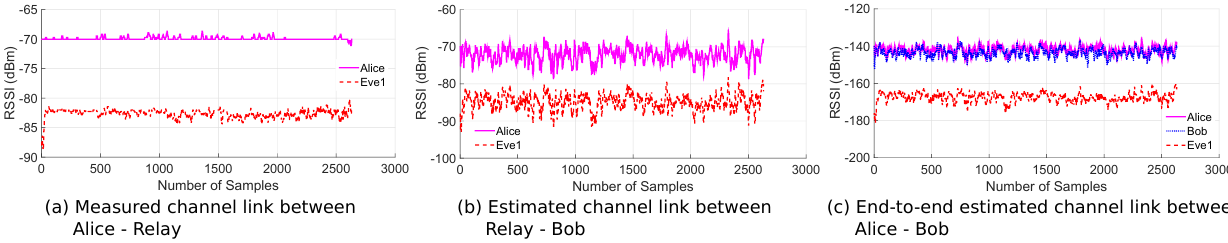
Figure 8: Channel estimation by Alice and Eve1 when two of the legitimate nodes i.e., Alice and Relay are stationary: ASRSBM.